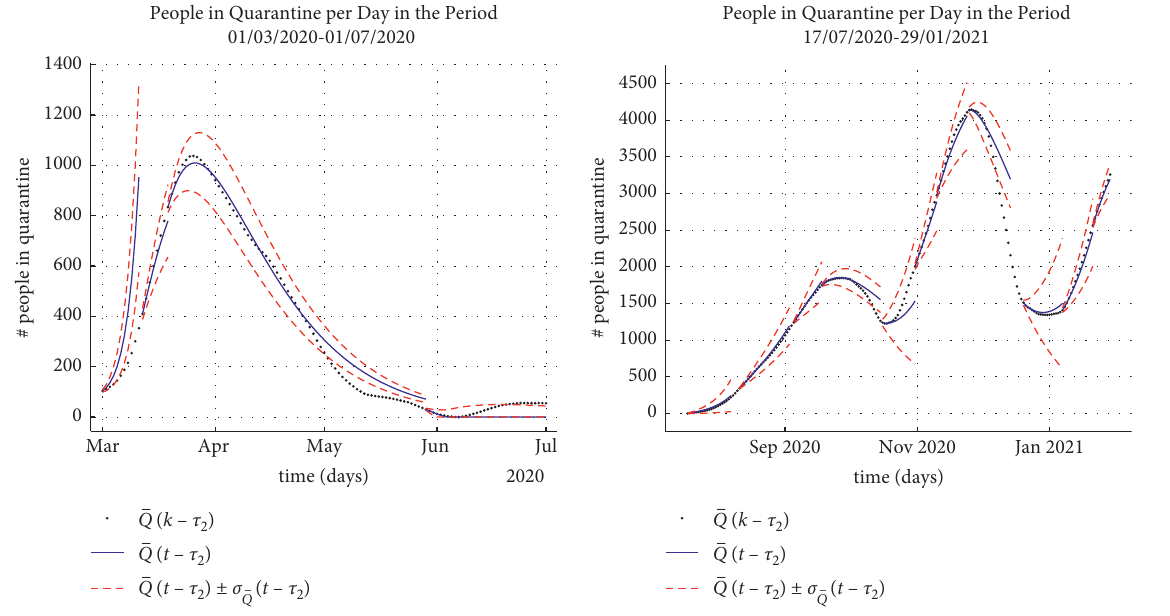
Figure 8: Comparison between measured people in quarantine per day (black dots) with respect to the estimated people in quarantine per day (blue solid line) with the estimated parameters. The dashed red lines show the standard error of the simulation.